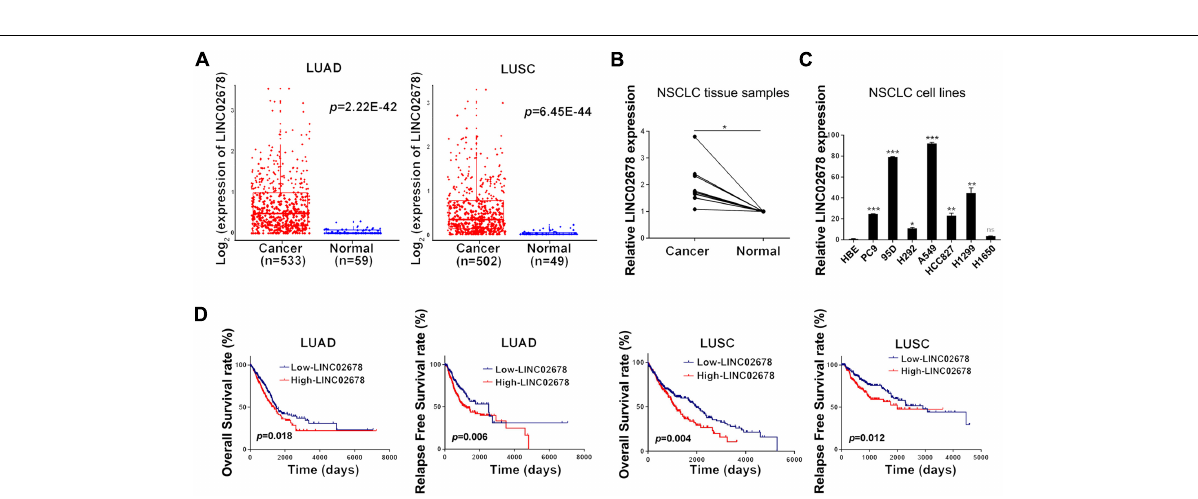
Frontiers in Cell and Developmental Biology |